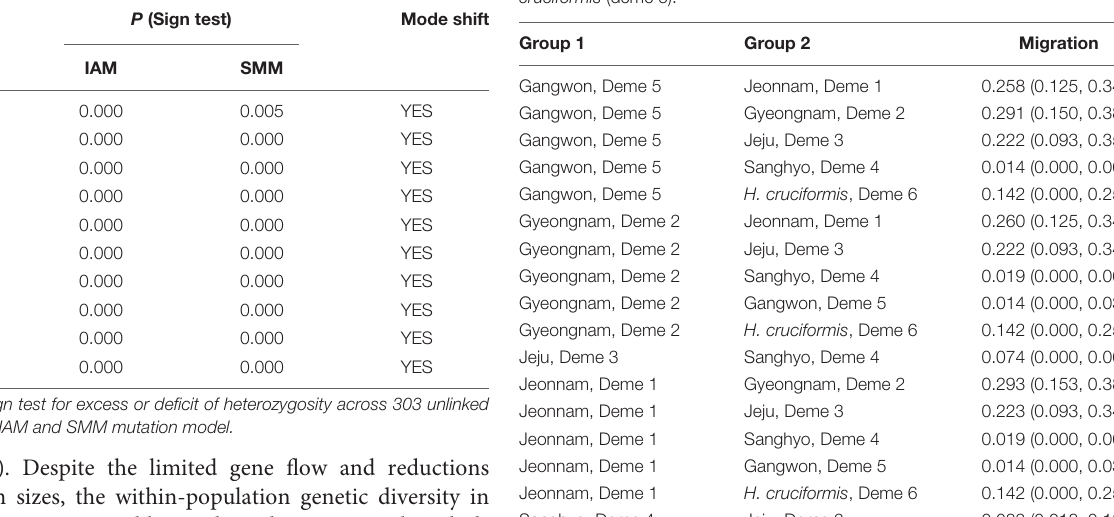
TABLE 5 | The migration rates computed from the thetas (mutation scaled effective population sizes) for five demes of Habenaria linearifolia and Habenaria cruciformis (deme